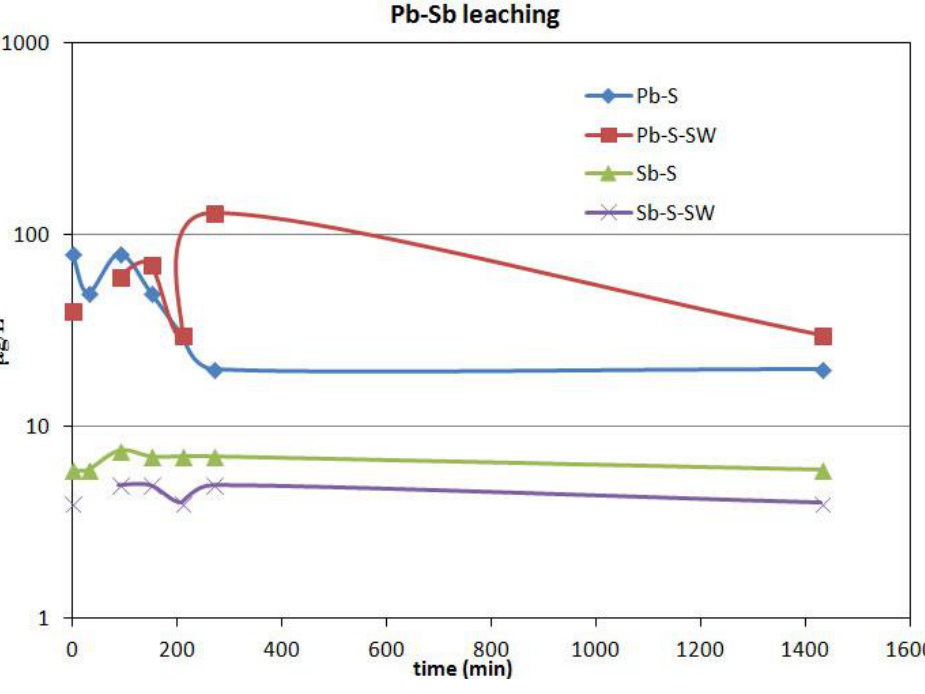
Figure 3. Evolution of Pb and Sb in the pilot-scale experiments. Values in μg/L. Pb/Sb-S: change of Pb and Sb content in time, measured in effluent solution of not-amended experiment; Pb/Sb-S-SW: change of Pb and Sb content in time, measured in effluent solution of amended